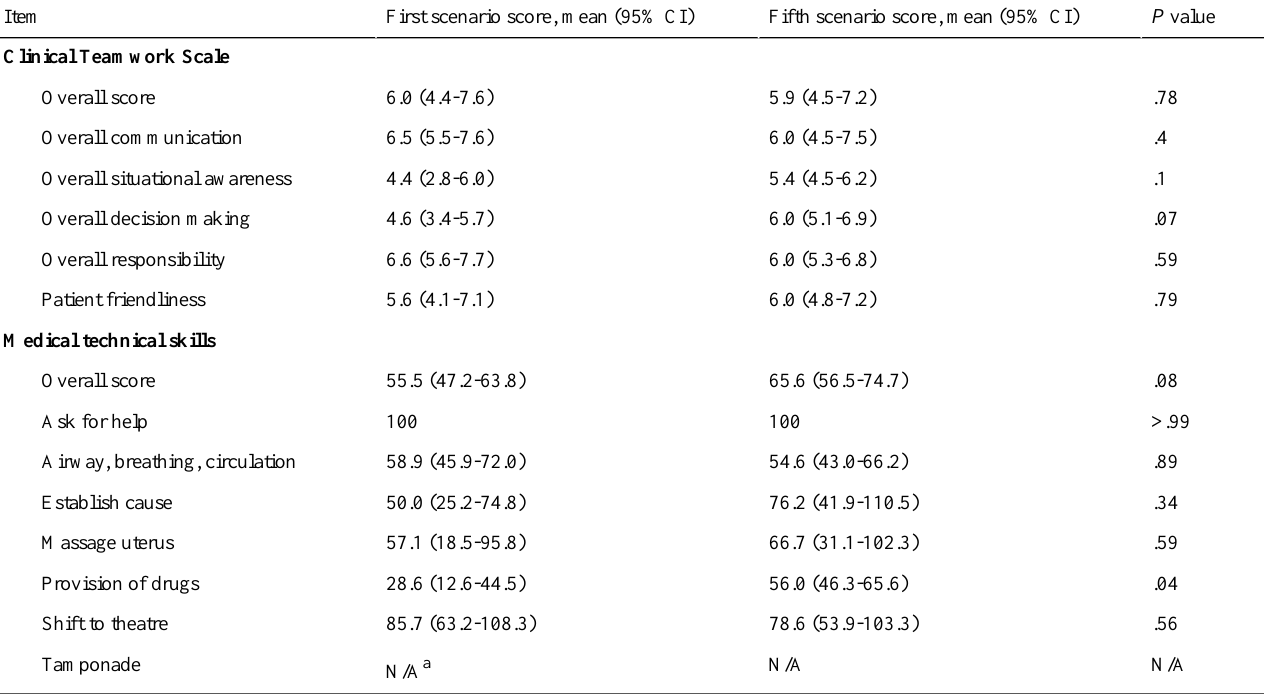
Table 3. Mean scores of senior house officers in clusters on the Clinical Teamwork Scale and the medical technical skills